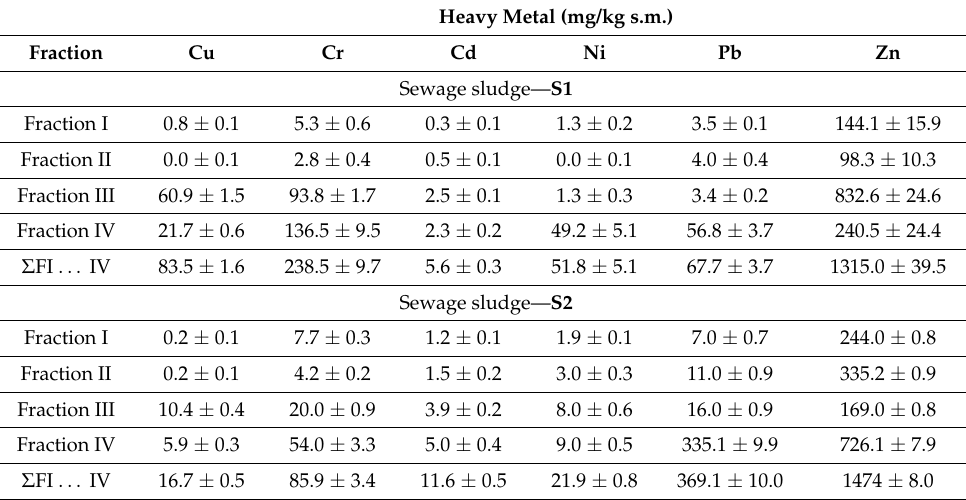
Table 6. Chemical speciation of heavy metal * in sewage sludge, mg · kg − 1 [31]. Heavy Metal (mg/kg